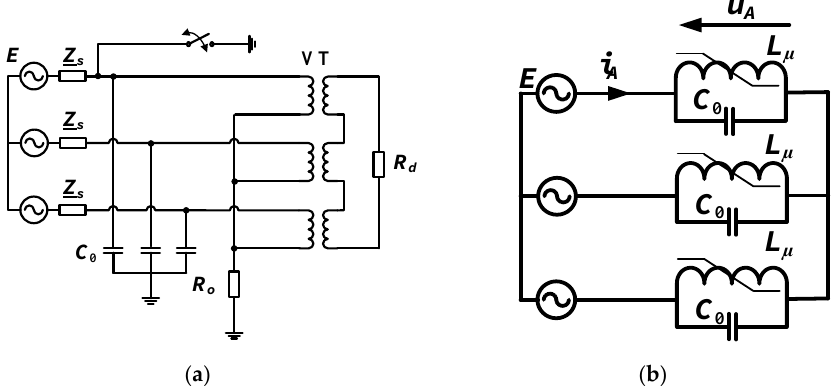
Figure 1. Basic medium voltage (MV) power system for ferroresonance studies: ( a ) model developed in MATLAB/Simulink; ( b ) simplified scheme.